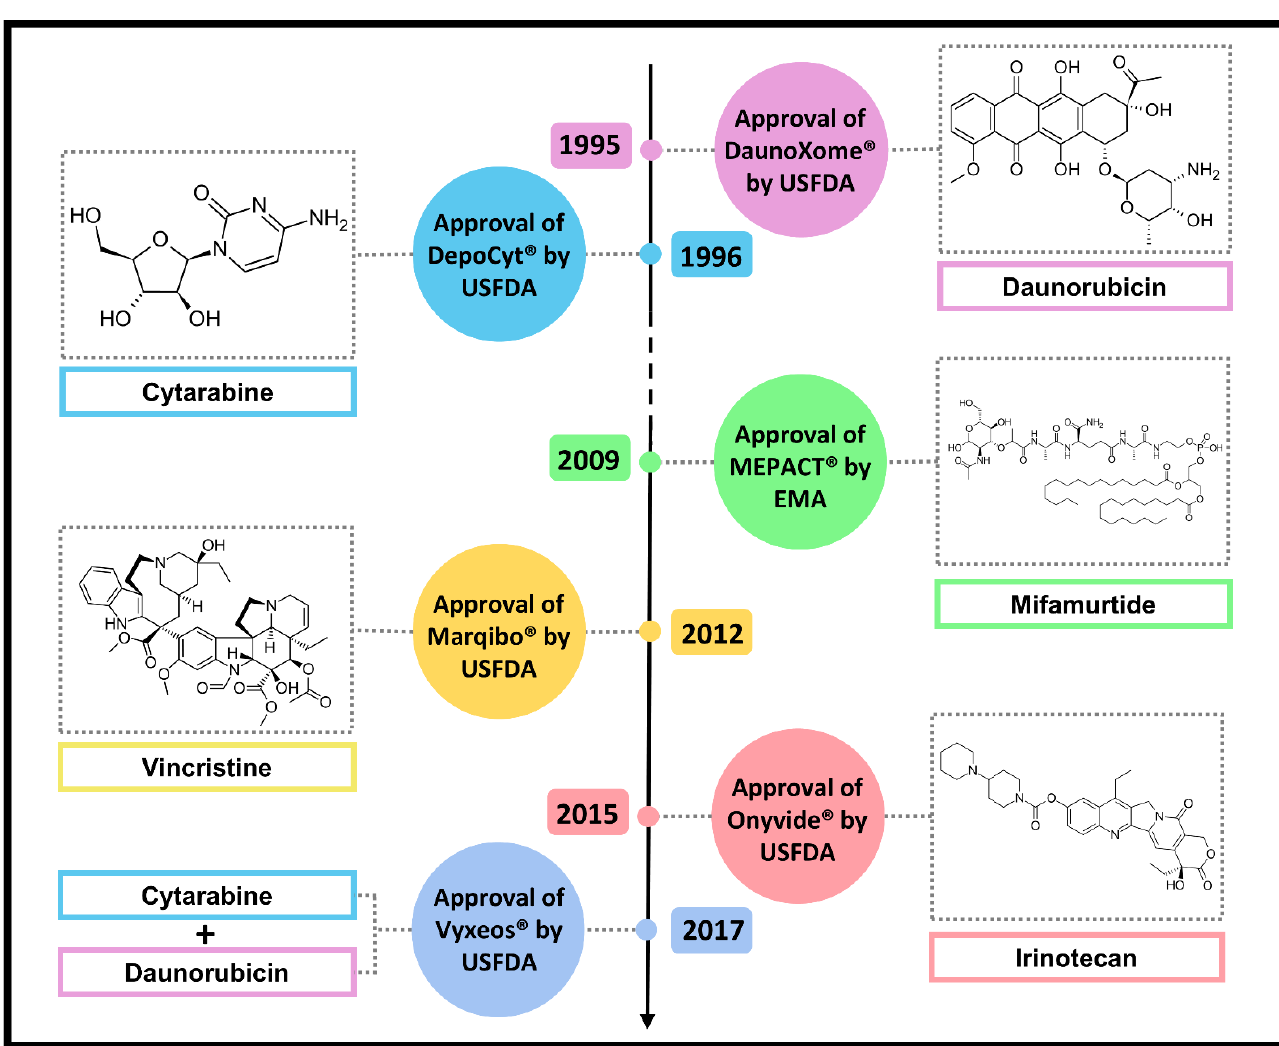
Figure 6. Timeline for approval of other natural-product-derived anticancer drugs, considering their nanotechnology-based dosage forms (USFDA — U.S. Food and Drug Administration; EMA — European Medicines Agency).